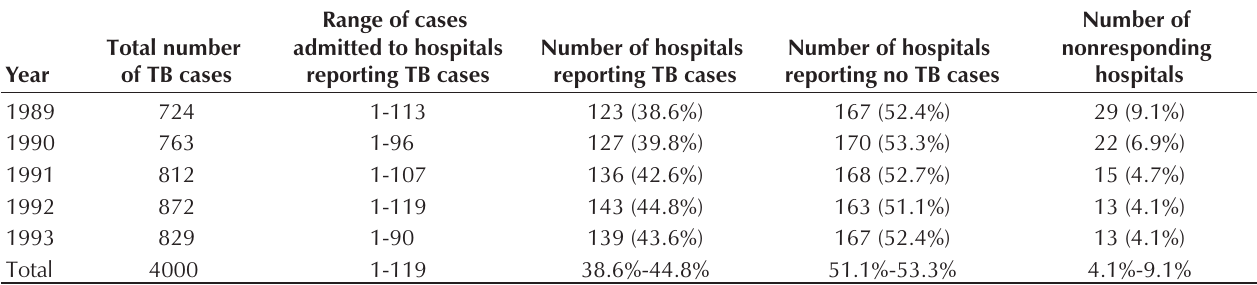
Cases of respiratory tuberculosis (TB) reported by acute care hospitals 1989 to 1993